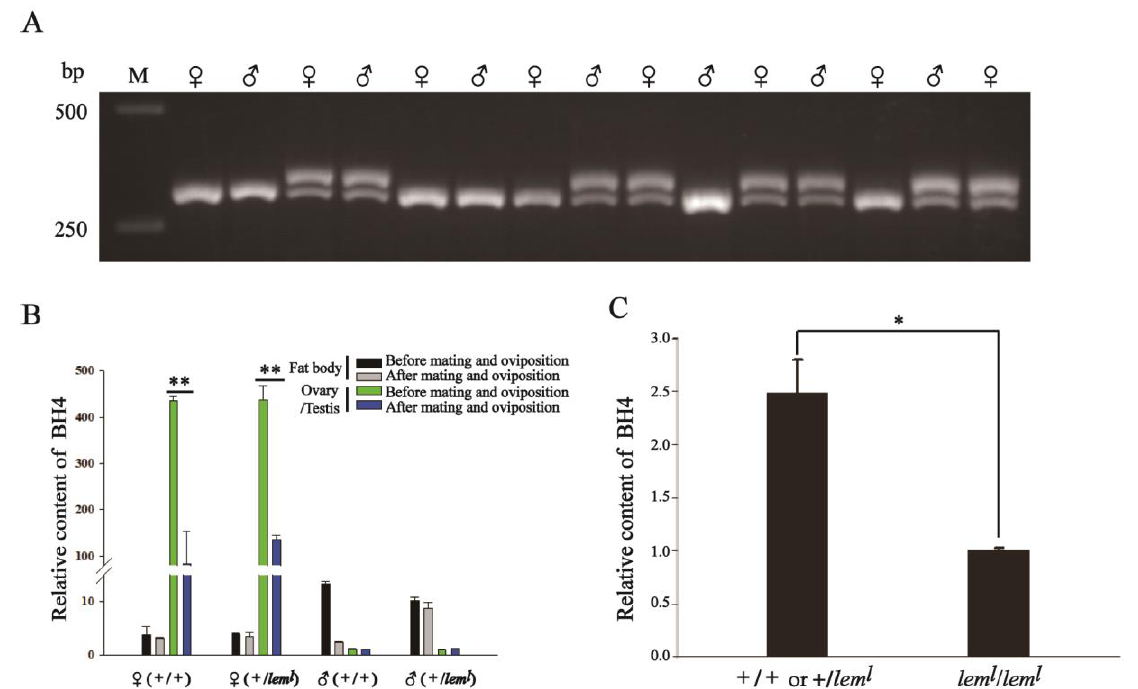
Figure 1. BH4 was transferred to fertilized eggs after oviposition in lem l heterozygous female moths. ( A ). Genotypic identification of genomic DNA in lem l moth. M: marker, the bottom one is 250 bp, the top one is 500 bp. ♀ represents the female moth, ♂ represents the male moth. The lane with a single band indicates homozygotes with genotype +/+, and the lane with two bands indicates heterozygotes with genotype +/ lem l . ( B ) The relative content of BH4 in fat body and gonads of lem l heterozygous moth. ( C ). The relative content of BH4 in lem l second-instar silkworms. Error bars represent mean ± SD; * p < 0.05; ** p < 0.01.